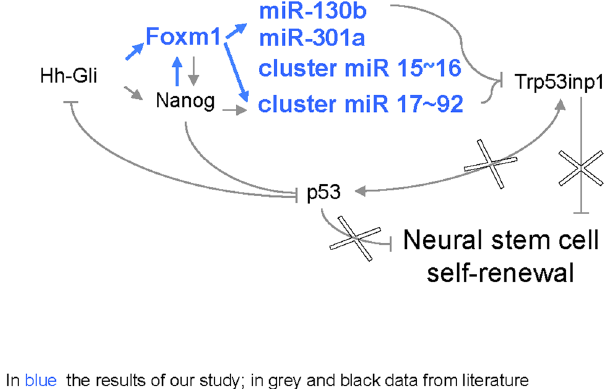
Figure 7. Regulation of cerebellar NSC self-renewal by the Hh-Foxm1-miRNA axis. Increased Hh-Gli signalling promotes NSC self-renewal by inhibiting p53 and upregulating Nanog expression. The